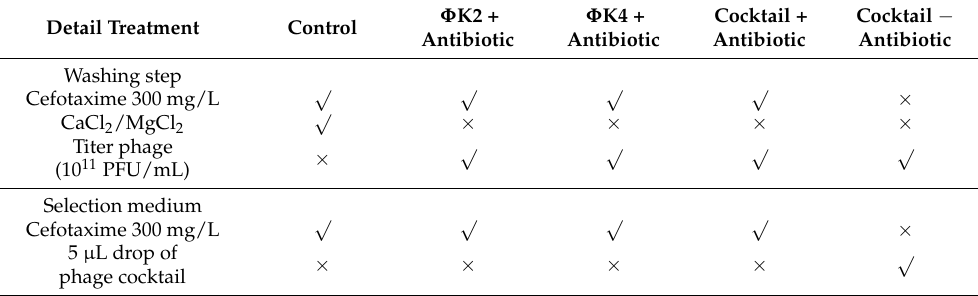
Table 4. Treatment details for overgrowth observation on rice